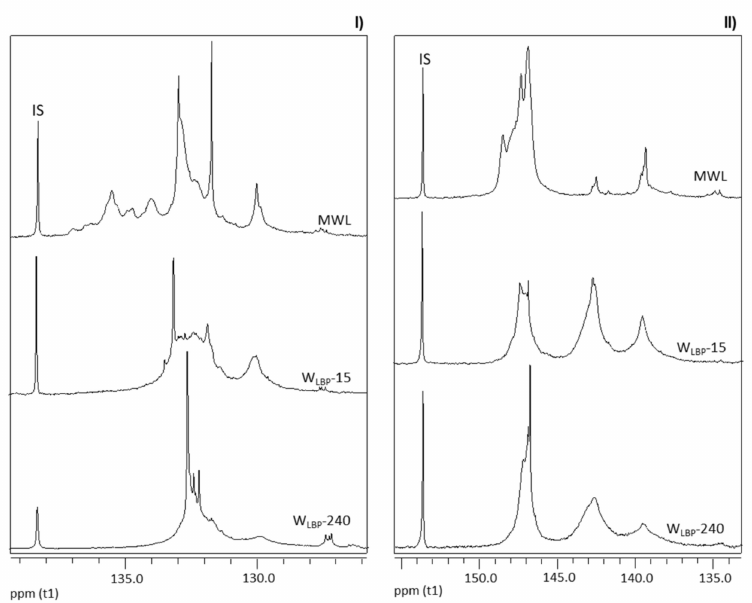
Figure 3. Quantitative 31 P NMR spectra of the MWL, W LBP -15 (15 min of liquefaction treat- ment) and W LBP -240 (240 min of liquefaction treatment) samples, derivatized with 2-chloro-1,3,2-